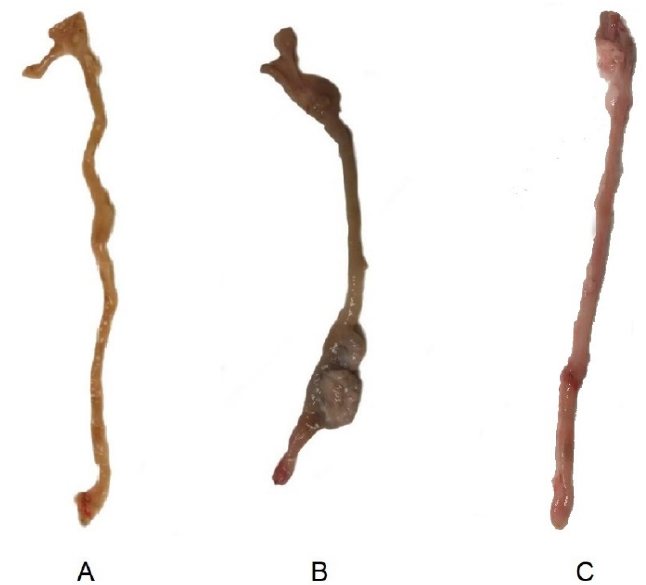
Figure 9. Macroscopic images of ex-vivo colons on day 15 post-TNBS induction in ( A ) control group (healthy animals) (13), ( B ) non-treated inflammatory bowel disease (IBD) rats, and (13) ( C ) IBD rats treated with tacrolimus.